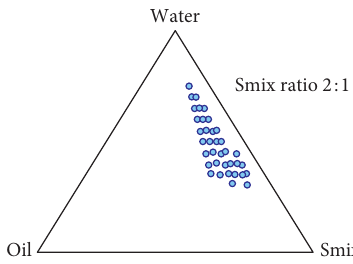
Figure 1: Pseudoternary phase diagram of DFS-NE at Km 2 :1. Table 1: Percentage composition of optimized DFS-NE